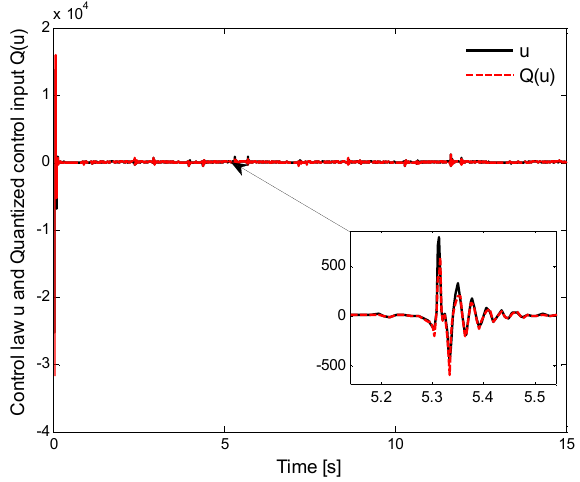
Figure 10. Trajectories of control law u ( t ) and quantized control input Q ( u ) .